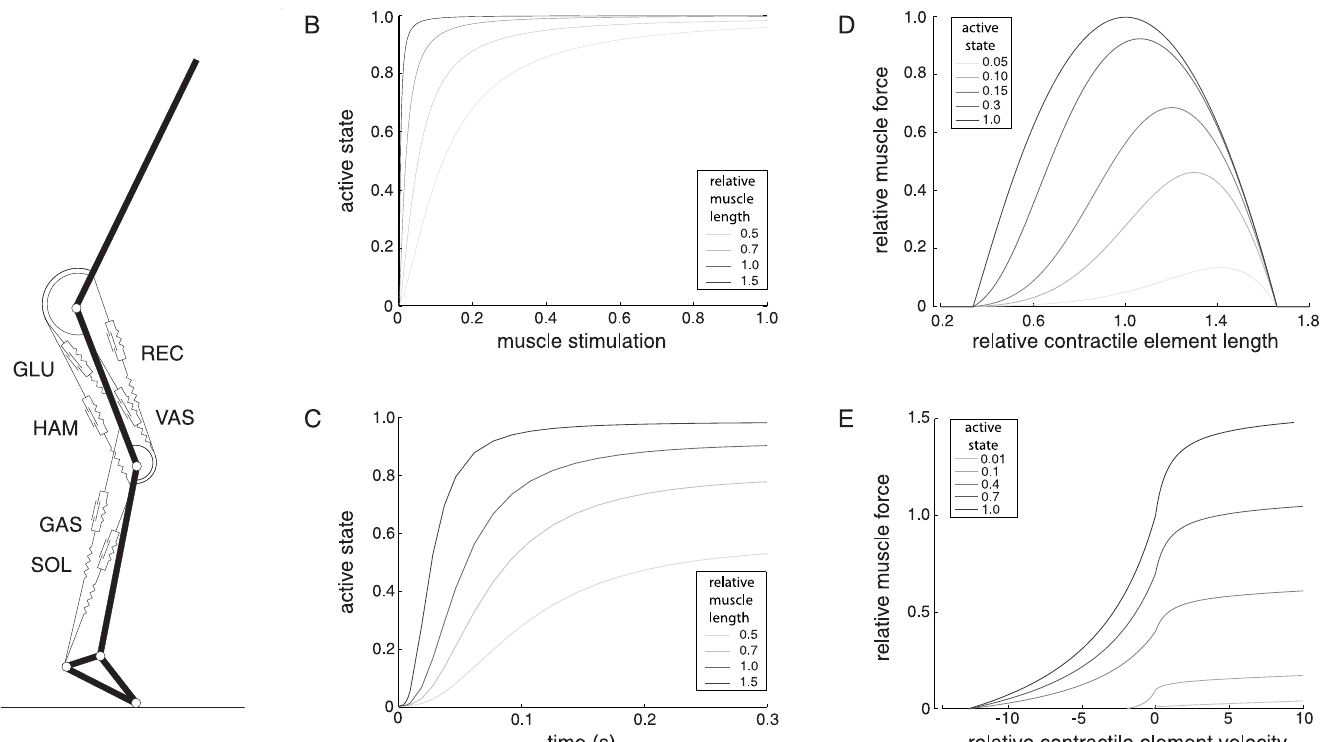
Fig 1. Musculoskeletal model. The muscle model has been used extensively in previous work, and a complete description is documented in [17]. A . The body was modeled as a four segment inverted pendulum connected with pin joints. B-E Muscle model. B . In steady state, the active state (relative amount of bound [Ca 2+] to troponin) of the muscle is a function of muscle stimulation and muscle length. C . Active state of the muscle over time, at different isometric muscle lengths. D . The force-length relationship is parabolic, the shape and peak of which shifts with the active state of the muscle. E . The force-velocity relationship captures the dynamics described in [18] during concentric contraction. The eccentric part of the force-velocity relationship was modeled using a hyperbola and at infinitely high velocity asymptotically approaches 1.5 times isometric force. Muscles are as follows: GLU = gluteus; HAM = hamstrings; VAS = vastus; REC = rectus femoris; SOL = soleus; GAS =